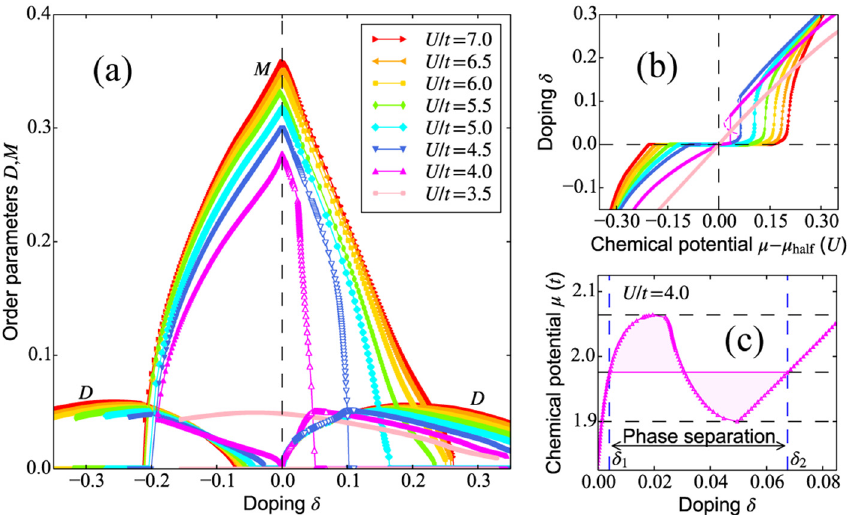
Figure 8. VCA calculations. ( a ) Antiferromagnetic and dx 2 − dy 2 superconducting order parameters, M and D , respectively, vs. doping concentration, δ , for several values of U / t . M and D for metastable and unstable solutions (empty symbols) at U/t = 4 and 4.5 under electron doping (corresponding to positive d) are also shown. ( b ) Doping concentration, δ , vs. chemical potential, µ , relative to that at half filling ( µ half ) for several values of U / t . The results for metastable and unstable solutions at U / t = 4 and 4.5 are indicated by dashed lines, and the results obtained by the Maxwell construction are denoted by solid vertical lines. The results imply the presence of phase separation and a first-order phase transition. It is noteworthy that there is a steep (nearly vertical) increase in δ with increasing µ for larger values of U / t under electron doping, suggesting a strong tendency toward phase separation. ( c ) Chemical potential, µ , vs. doping concentration, δ , for U / t = 4. δ 1 and δ 2 are the doping concentrations of the two extreme states in the phase separation. All results in ( a ) to ( c ) were calculated using VCA for the single-band Hubbard model on an anisotropic triangular lattice ( t (cid:48) / t = − 0.44) with a 4 × 3